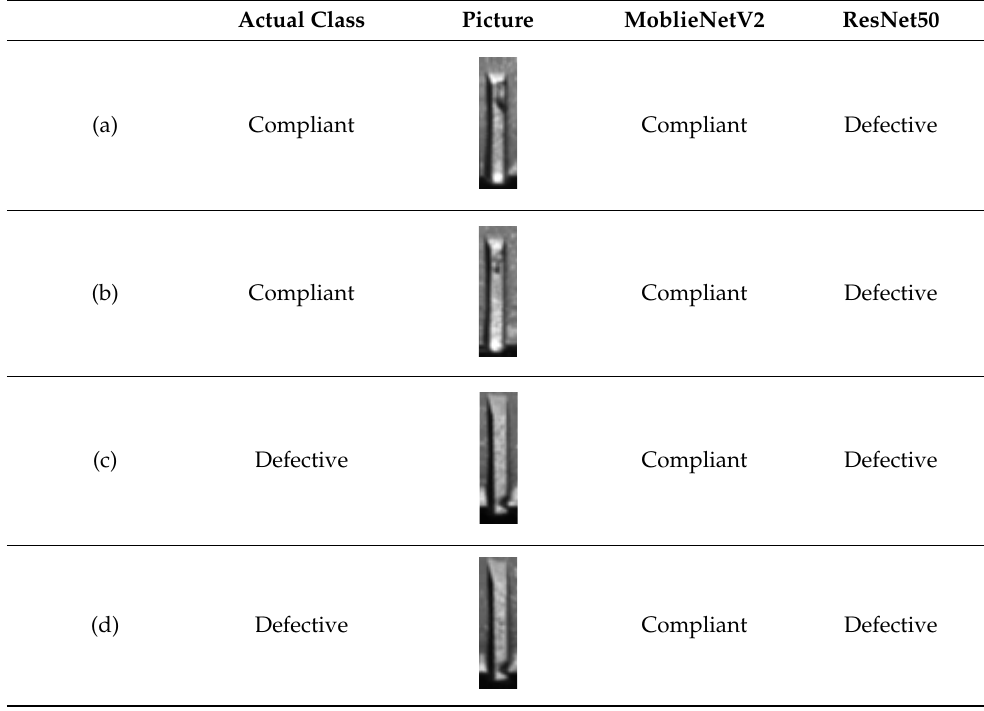
Figure 14. Training history of ResNet50 architecture. Table 5. Misclassified teeth by different models.